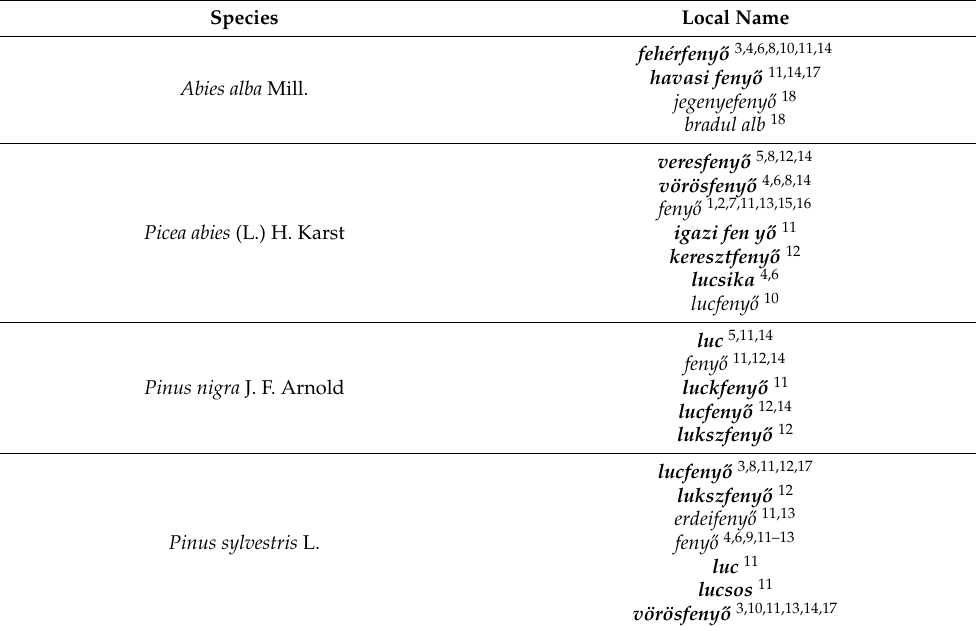
Table 1. Local names of the pine species in the study